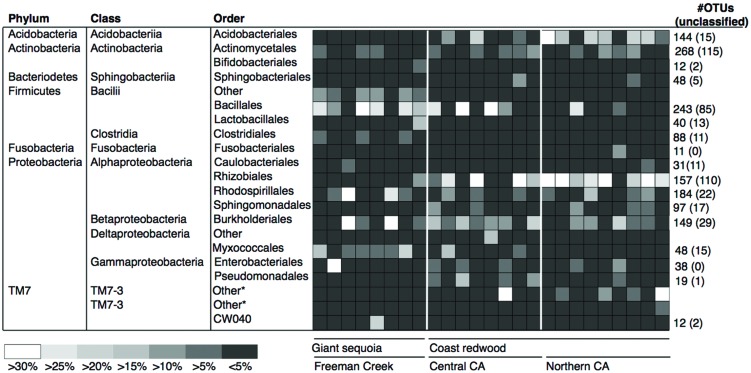
Heatmap showing the 20 most dominant orders in our dataset and their average relative abundances as percentages of all 16S rRNA gene sequences recovered in our foliage samples, along with the total number of operational taxonomic units (OTUs) in each order. The number of OTUs in each order that could not be classified below the order level is shown within parenthesis. Color tones range from white to dark gray to indicate the highest to lowest relative abundance values.